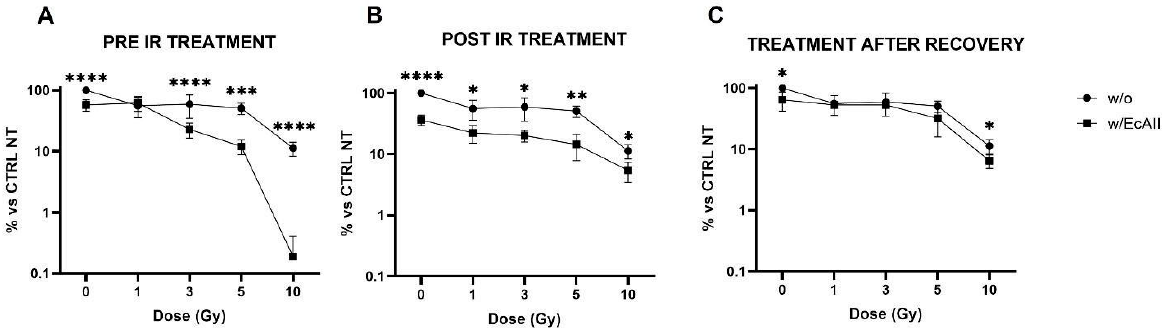
Figure 1. Clonogenic survival assay for Caco-2 cells exposed to different doses of X rays (0, 1, 3, 5 and 10 Gy), without (w/o, black bars) or with 1 U/mL EcAII (w/EcAII, gray bars) treatment, with different treatment schemes. Data are expressed as the percentage of colonies counted with respect to the unirradiated and untreated sample (% vs. CTRL NT). Data are the mean ± SD obtained from at least three independent experiments. Panel ( A ), Caco-2 cells treated with EcAII before X-ray exposure, colonies counted at day 10. Panel ( B ), Caco-2 cells treated with EcAII immediately after X-ray exposure, colonies counted at day 10. Panel ( C ), Caco-2 cells treated with EcAII after 10 days from X-ray exposure, colonies counted at day 13. Statistical significance (Student’s t -test) was calculated comparing the w/o and w/EcAII conditions for each dose, and reported as follows: * p < 0.05, ** p < 0.01, *** p < 0.001, **** p < 0.0001.